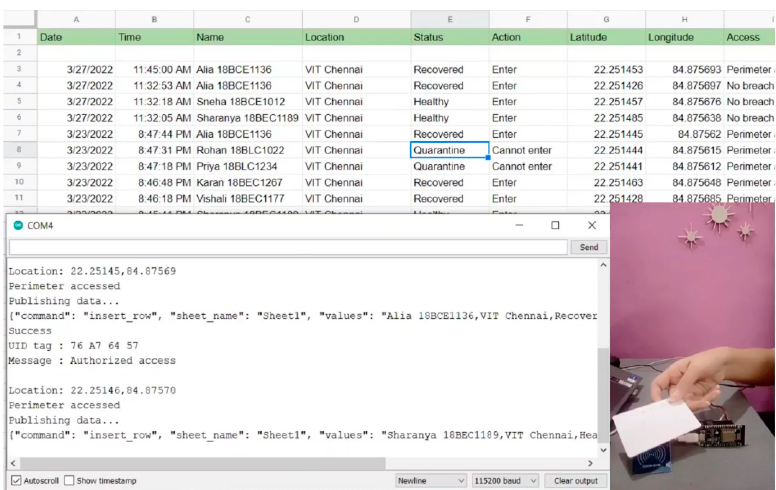
Figure 8. Location and status update in the COM port window and log screen after the RFID tag was scanned. Table 2. Comparison of our proposed work with the existing literature .